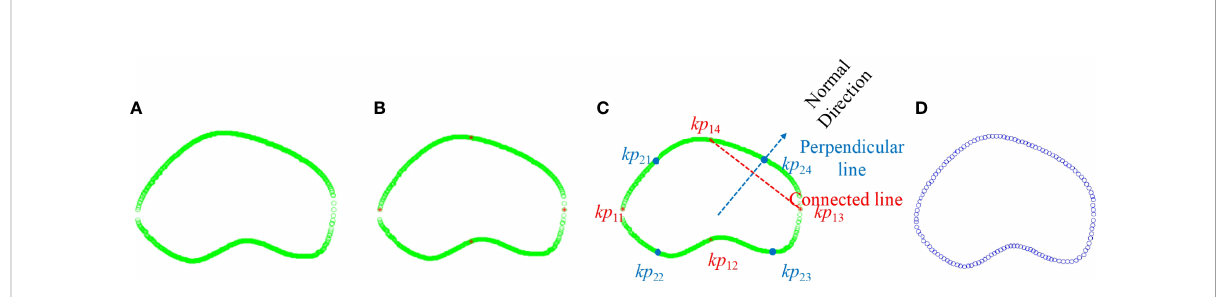
FIGURE 3 Illustration of candidate point selection and fi ner boundary detection. (A) Green — point selection after extra point removal; red — key points. (B) Detection of four salient points. (C) Interpolation of the fi rst iteration. (D) Finer